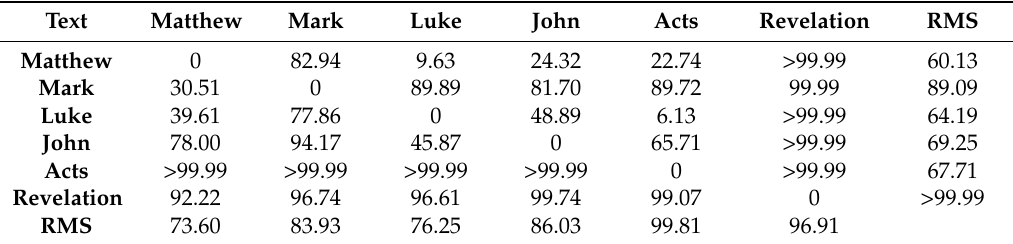
Table 9. Full Texts. Kolmogorov–Smirnov test results for 𝐼 𝑃 (below the diagonal of zeros) and 𝑀 𝐹 (above the diagonal). The values reported are the confidence level (%) that the indicated couple of probability distributions are not identical.